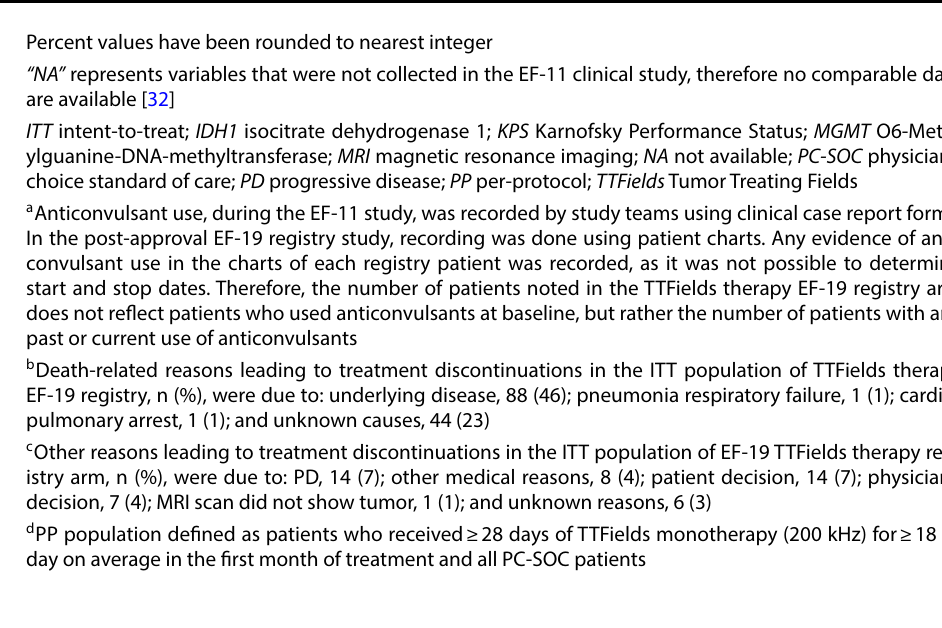
Percent values have been rounded to nearest integer “NA” represents variables that were not collected in the EF-11 clinical study, therefore no comparable data are available [32] ITT intent-to-treat; IDH1 isocitrate dehydrogenase 1; KPS Karnofsky Performance Status; MGMT O6-Meth- ylguanine-DNA-methyltransferase; MRI magnetic resonance imaging; NA not available; PC-SOC physicians’ choice standard of care; PD progressive disease; PP per-protocol; TTFields Tumor Treating Fields a Anticonvulsant use, during the EF-11 study, was recorded by study teams using clinical case report forms. In the post-approval EF-19 registry study, recording was done using patient charts. Any evidence of anti- convulsant use in the charts of each registry patient was recorded, as it was not possible to determine start and stop dates. Therefore, the number of patients noted in the TTFields therapy EF-19 registry arm does not reflect patients who used anticonvulsants at baseline, but rather the number of patients with any past or current use of anticonvulsants b Death-related reasons leading to treatment discontinuations in the ITT population of TTFields